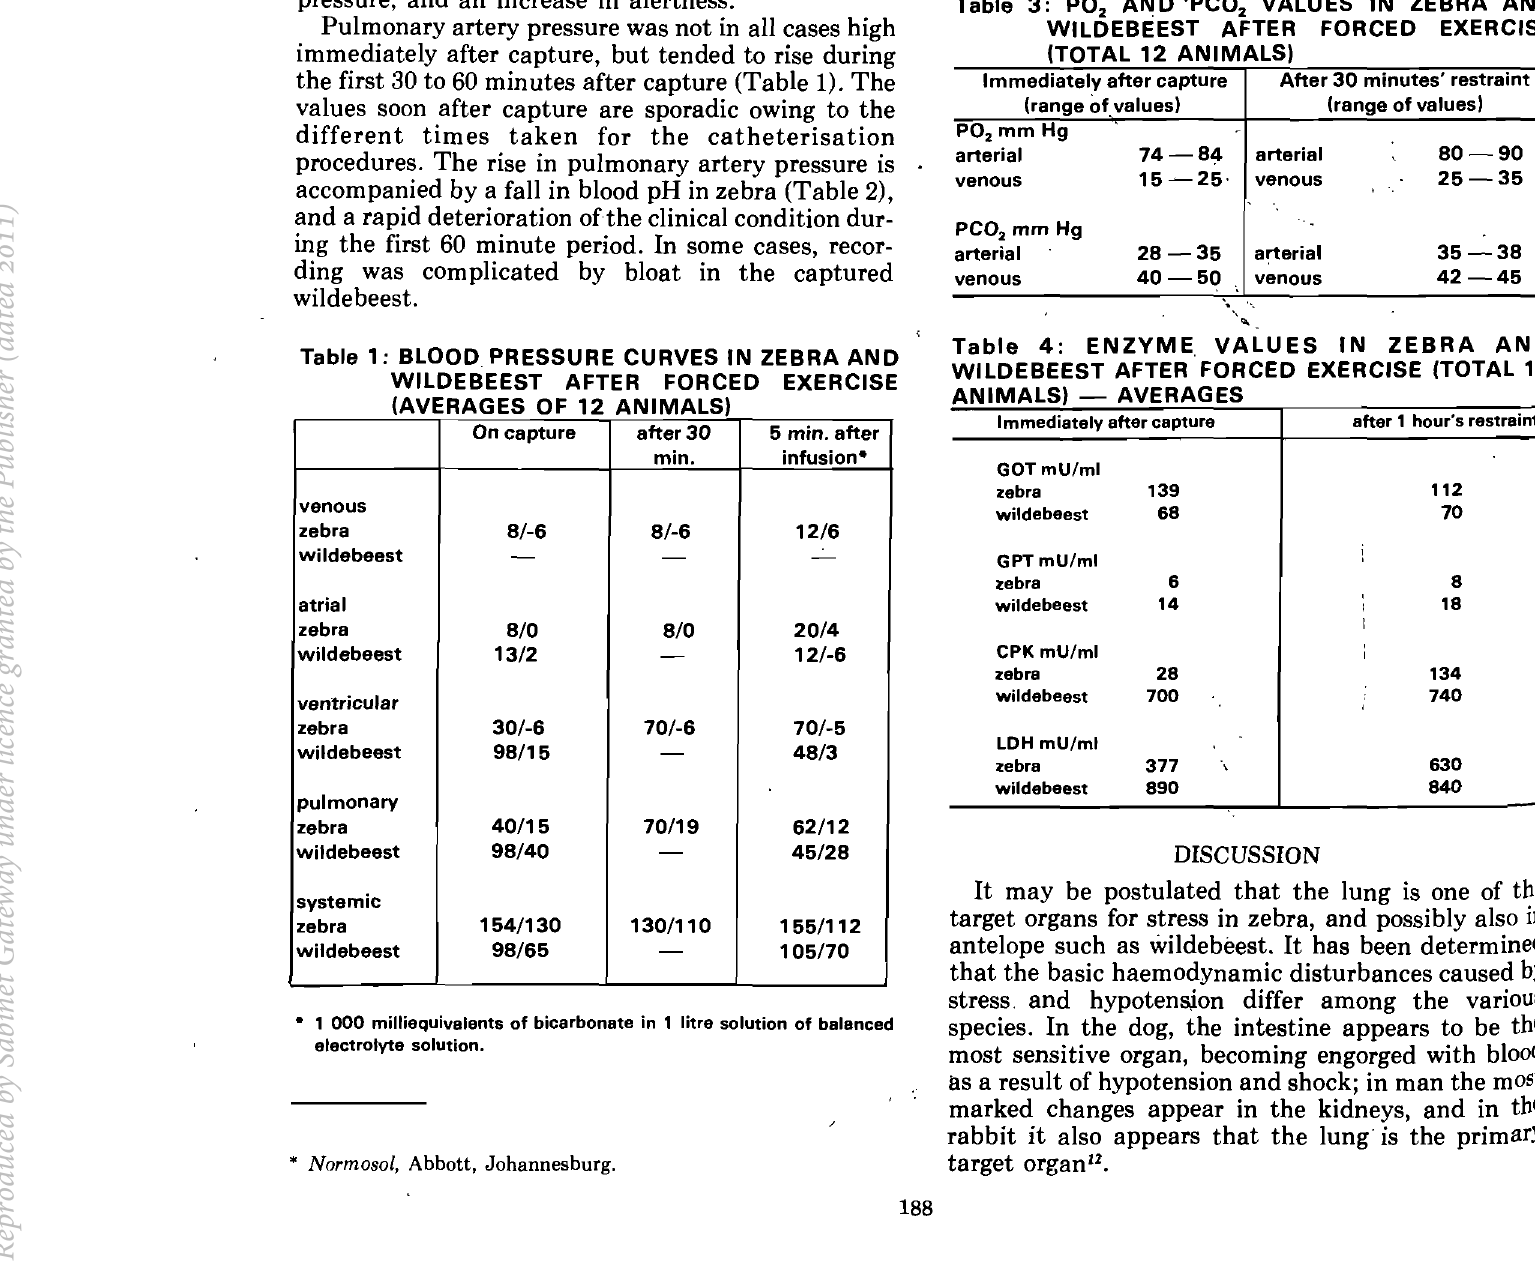
Table 3: P0 AND 'PC0 VALUES IN ZEBRA AND 2 2 WILDEBEEST AFTER FORCED EXERCISE (TOTAL 12 ANIMALS)